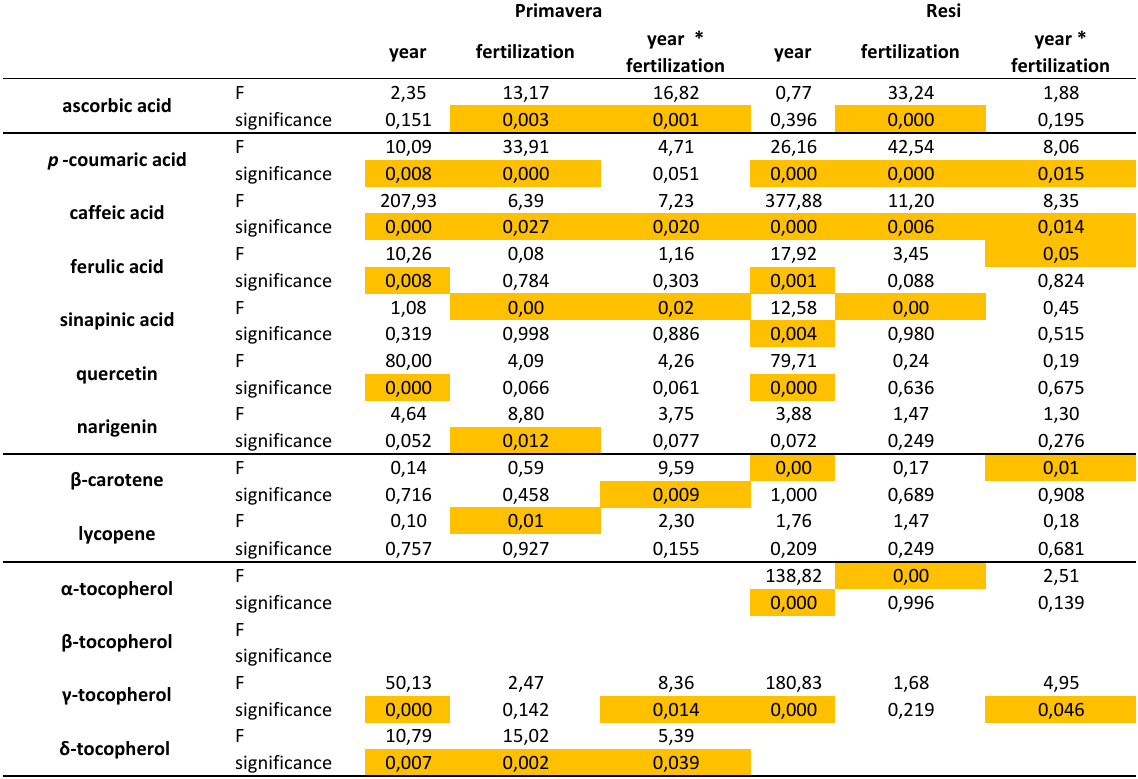
Table S2: Results of two-factorial analysis of variance (ANOVA) performed for the categorical variables “year” and “fertilization level” of each cultivar as well as each measurement